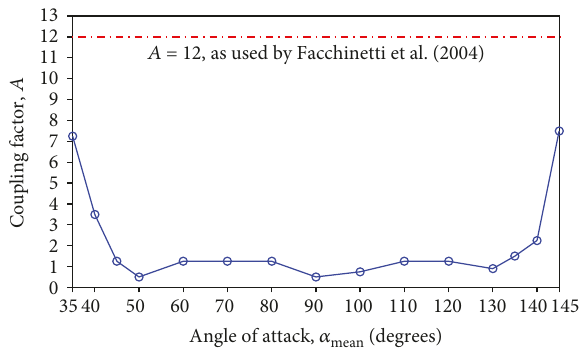
Figure 12: Variation of the coupling factor, A , with angle of attack, = 7 ° . Dash-dot line indicates the value used by [32] for a for α ampl circular cylinder.